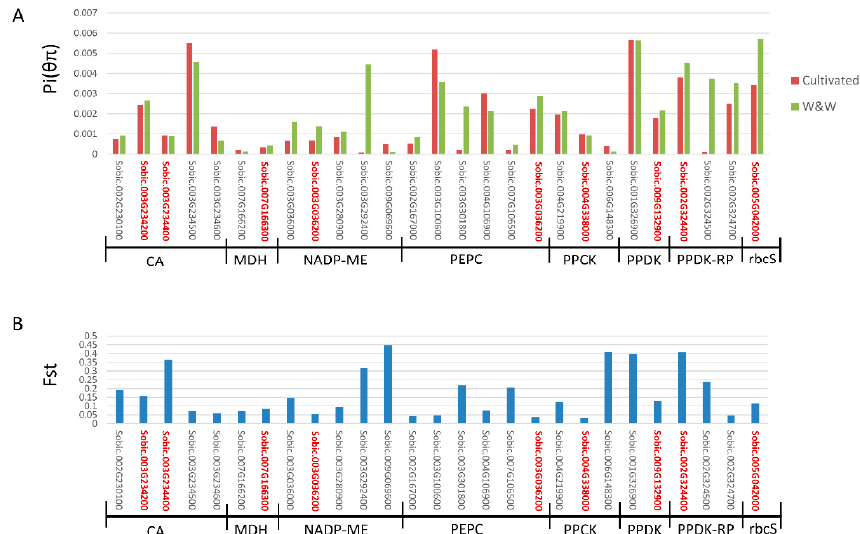
Figure 2. Genetic diversity and fixation index (F ST ) of C 4 gene families between cultivated sorghum and the wild and weedy group. ( A ) Genetic diversity (pi) for each of the C 4 gene families. Gene IDs in red indicate core C 4 genes. Red bars represent the pi of cultivated sorghum, while dark blue bars represent the pi of wild and weedy. ( B ) F ST between cultivated and wild and weedy of each of C 4 gene families. Gene IDs in red indicate core C 4 genes.